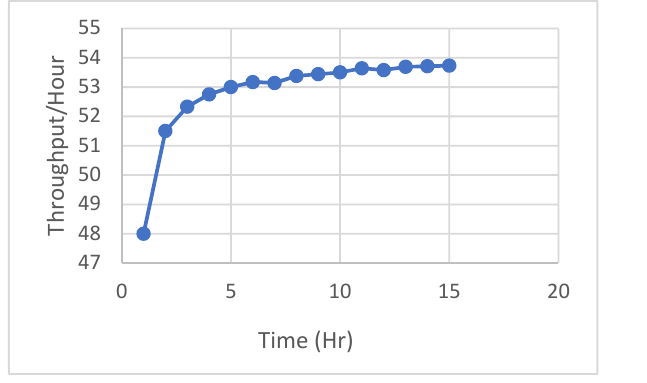
Figure 4. Plot of output to identify the warm-up period without breakdown of machines. ( a ) one degree. ( b ) two degrees. ( c ) semi-flexible. ( d ) fully flexible. ( a )